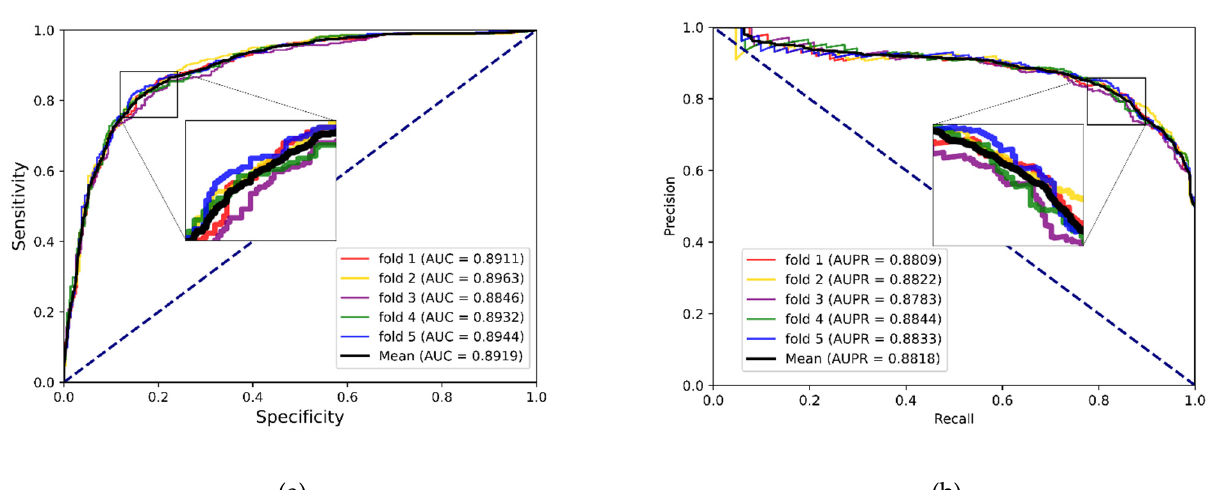
Figure 6. ( a ) The ROC curves of the result on the SM2miR datasets. ( b ) The PR curves of the result on Figure 6. (a)The ROC curves of the result on the SM2miR datasets. (b) The PR curves of the result on the SM2miR datasets. the SM2miR